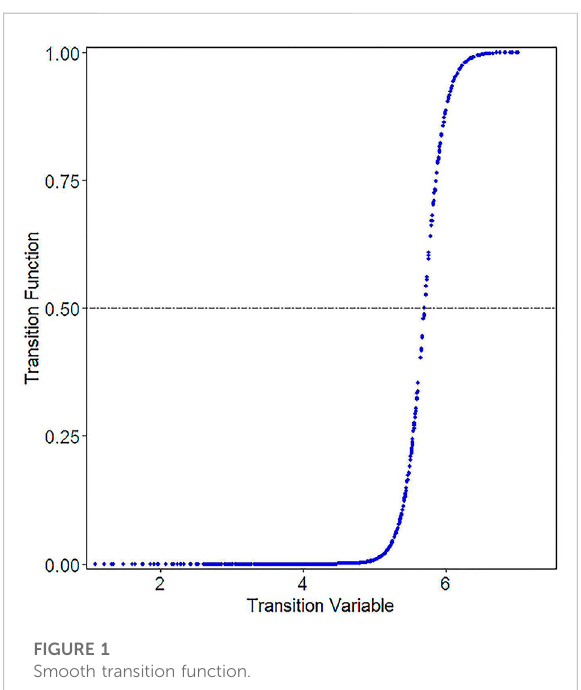
TABLE 7 Results of the PSTR estimation.